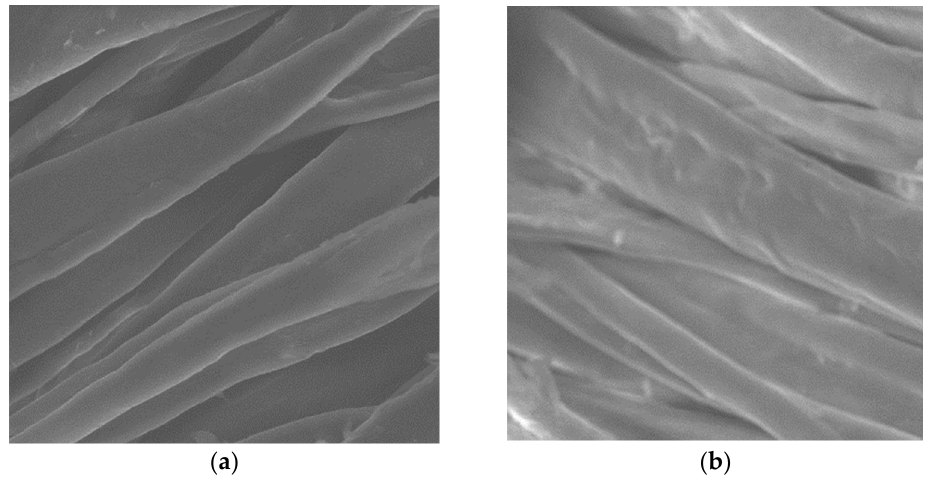
Figure 4. SEM images of ( a ) untreated cotton and ( b ) plasma-treated cotton.